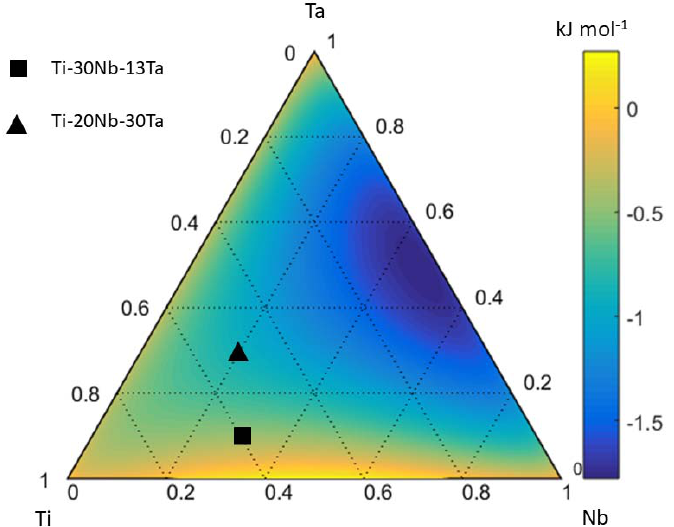
Figure 6. Ternary diagram of Gibbs free energy for the Ti ‐ Nb ‐ Ta system at 298 K.